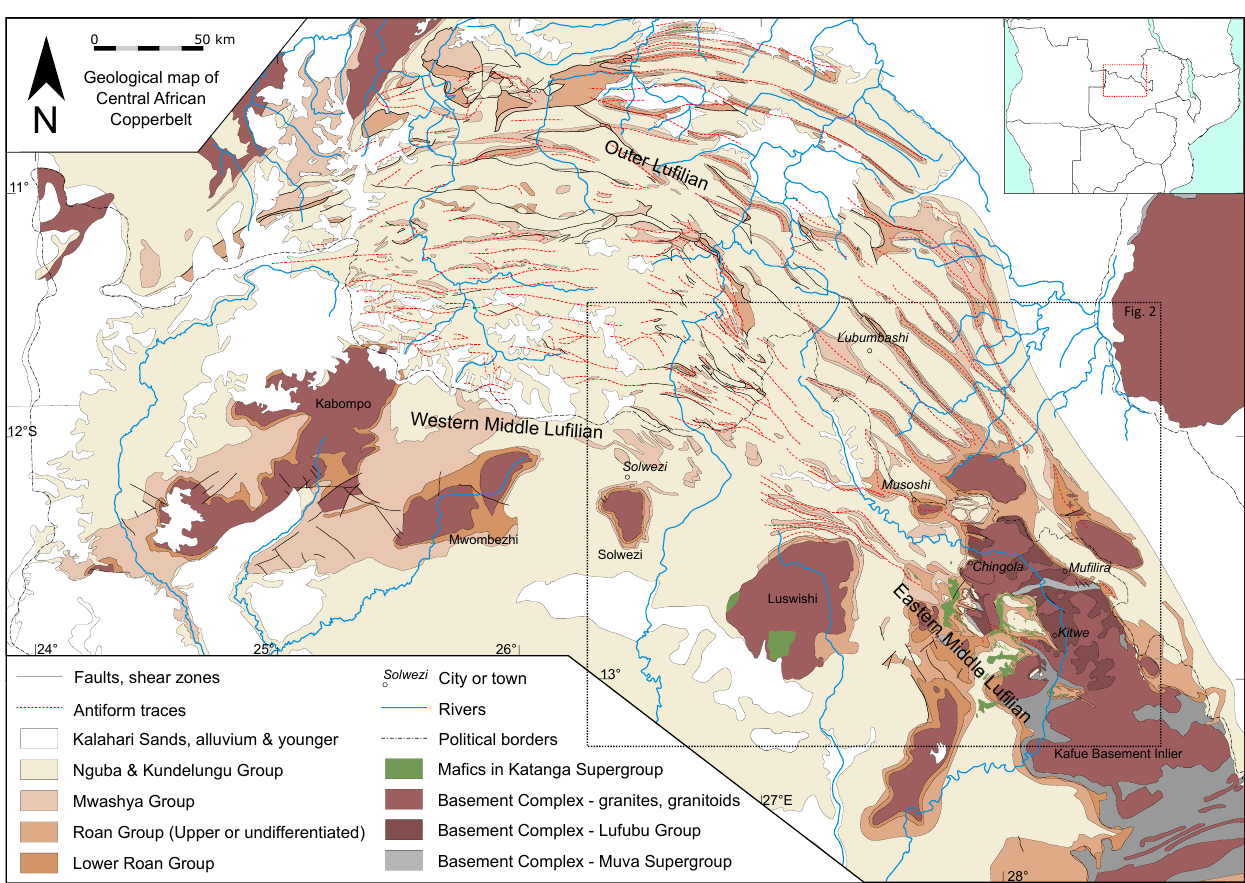
Figure 1. Geological map of the central part of the Central African Copperbelt. Geology is adapted from Thieme and Johnson (1981). Antiform traces are compiled and adapted from Brock (1961), François (1993) and Jackson et al. (2003). Basement subdivision in Kafue basement inlier is based on De Waele et al. (2006). Names of the basement inliers are indicated at their respective locations. Inset shows political borders and position in central